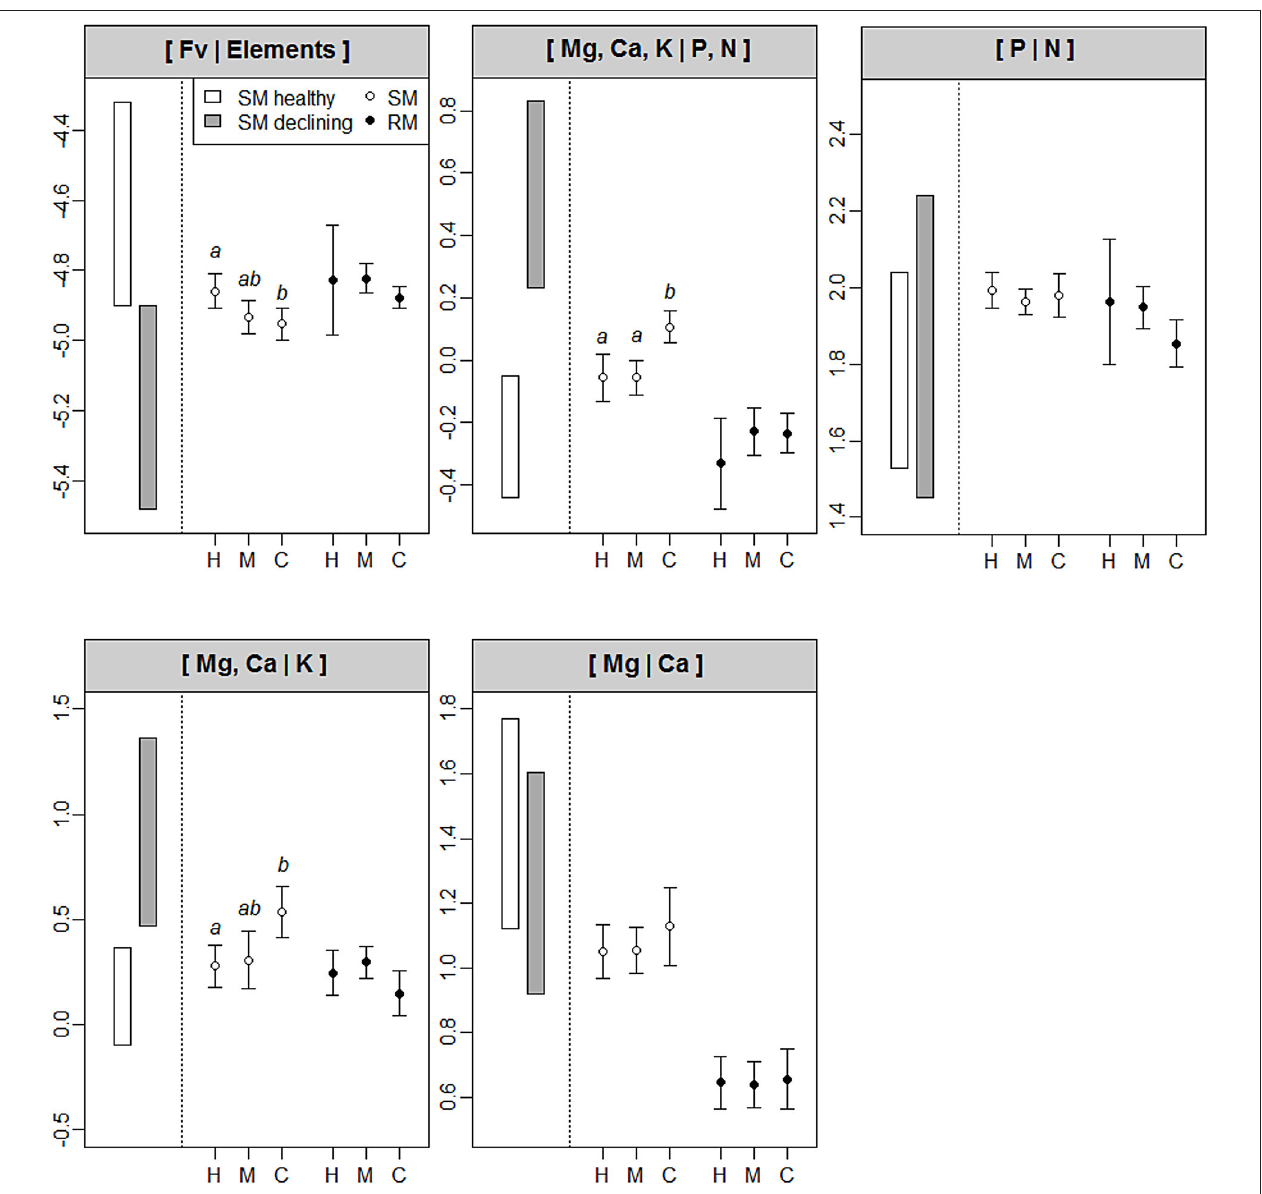
FIGURE 4 | Comparison of foliar ilr balances of sugar maple (SM) and red maple (RM) seedlings among forest types (H, hardwood stands; M, mixed hardwood-conifer stands; C, conifer-dominated stands). Rectangles on the left of each panel are foliar ilr balances based on literature data for healthy and declining SM stands (see Table 5 for details of references and values). Significant differences ( P < 0.05 ) in foliar balances between forest types (not between maple species) are indicated with different letters. A significantly lower balance indicates that concentrations of nutrients in the left part of the balance are significantly higher (or concentrations in right part lower), and